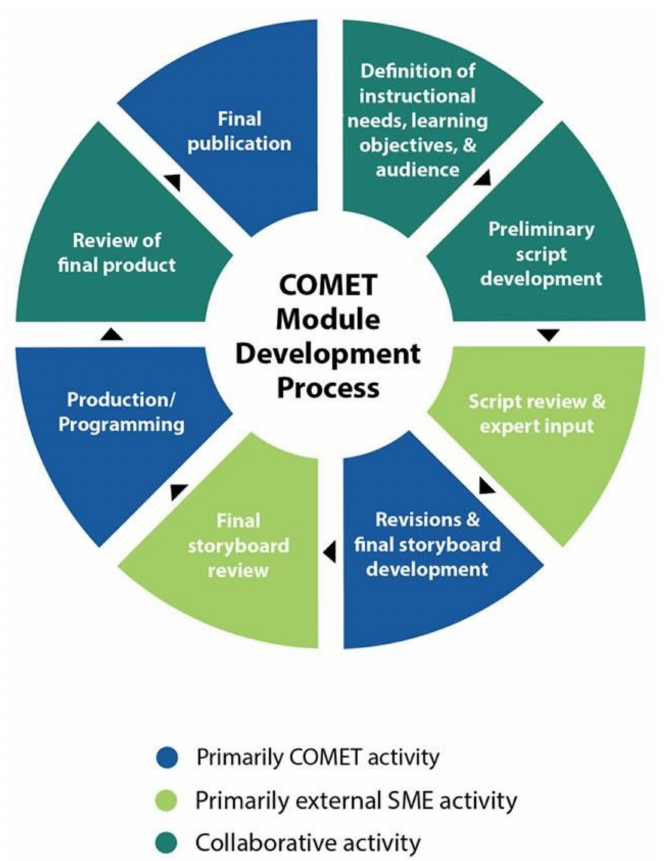
Figure 3. The training development process design follows from Alessi and Trollip’s 2001 [1] design and development model and incorporates the fundamental structure of the ADDIE (analysis, design, development, implementation, and evaluation) method combined with some elements of the successive approximation model (SAM)